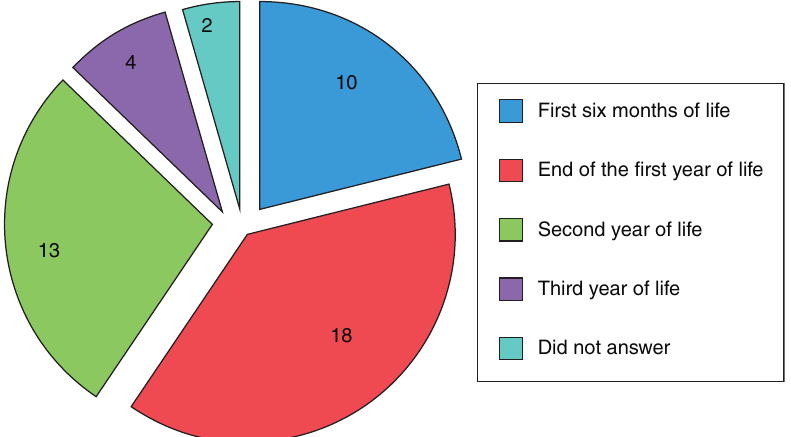
Figure 7 Age at which the child can undergo speech therapy for hearing loss ( n =